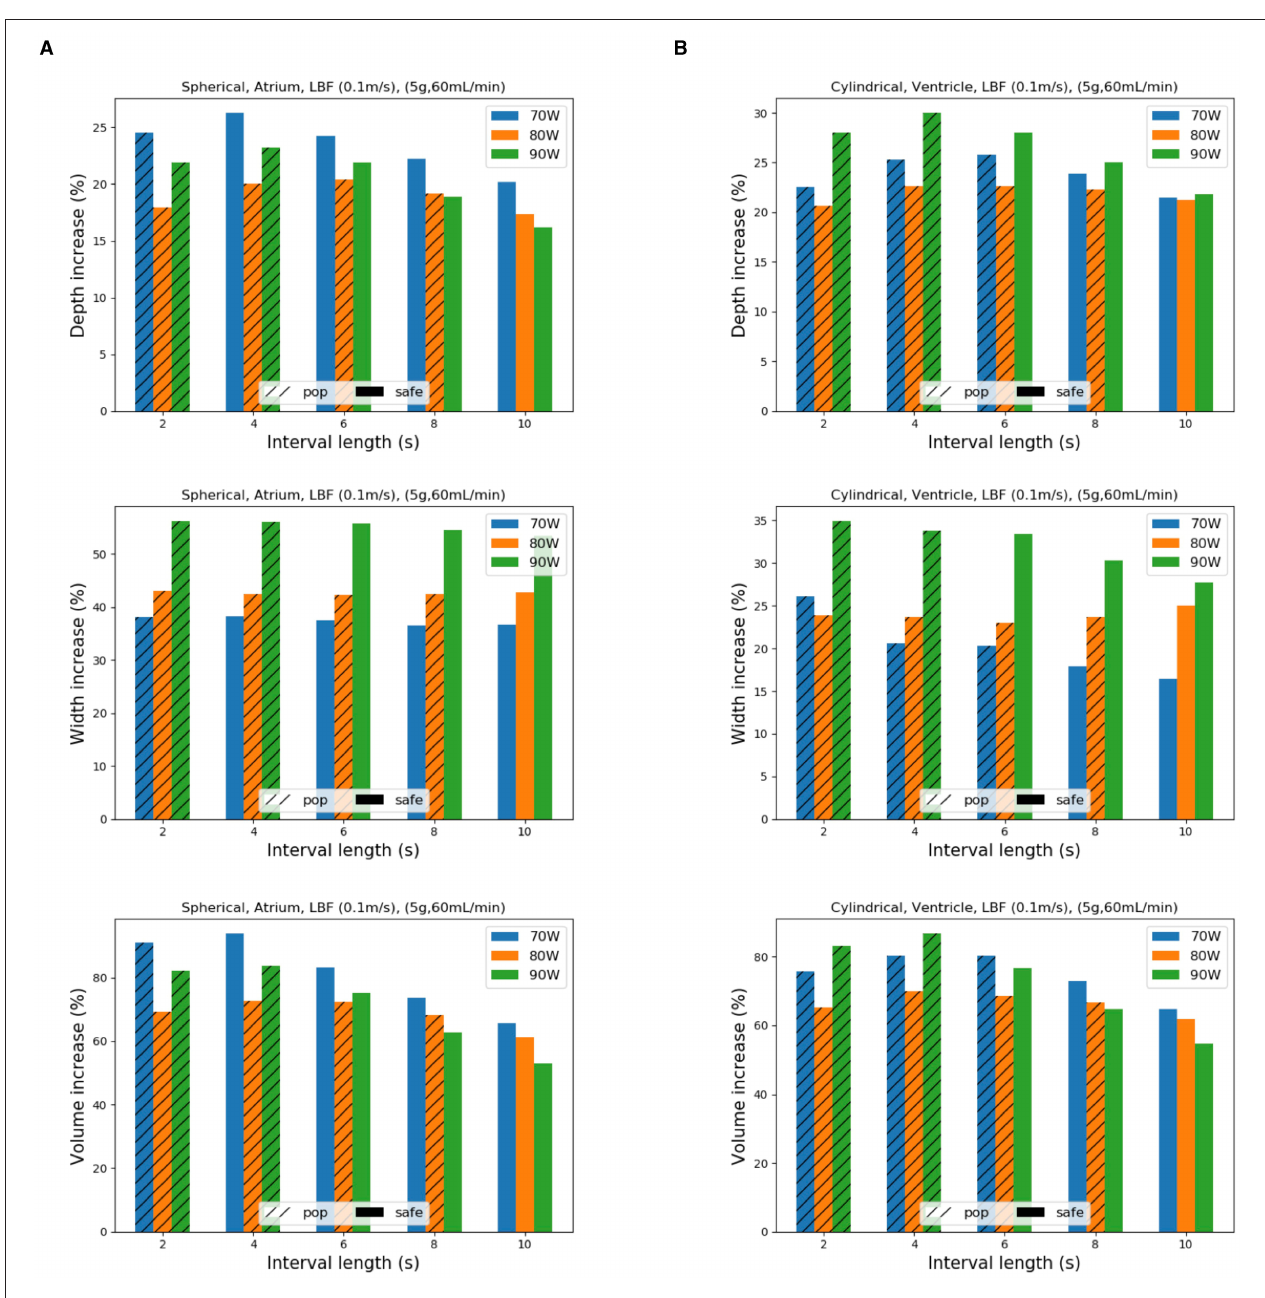
FIGURE 6 | Effect on lesion size from a second HPSD application on top of a first one as a function of the time interval between the two. Ablations are performed with spherical tip in the atrium and cylindrical tip in the ventricle. The percentage increase in depth, width and volume is represented as bar charts for atrium (A) and ventricle (B) . Striped bars indicate a pop occurrence during the second